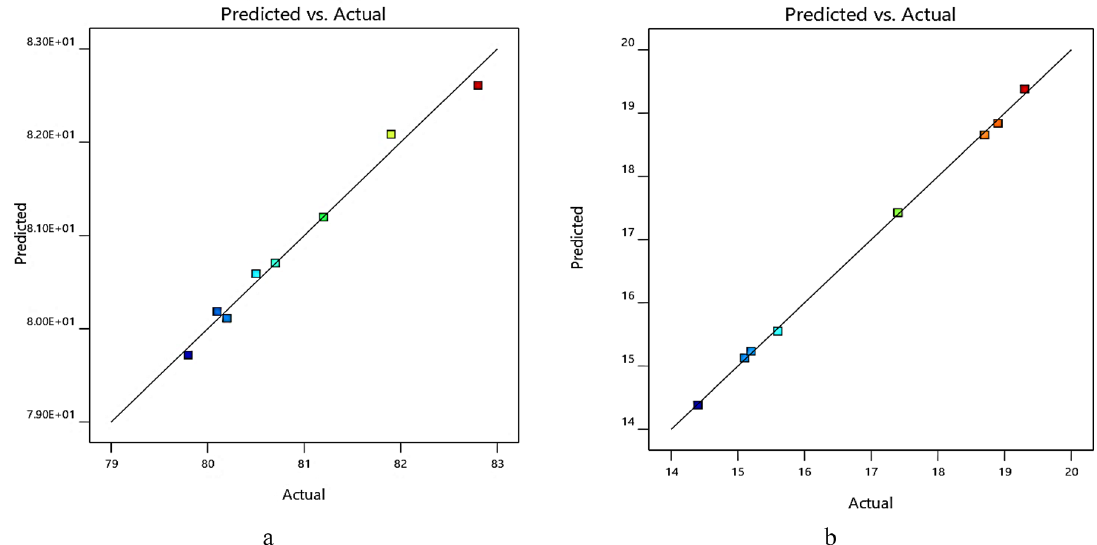
Figure 19. Results of the modeling and predicted values by the statistical model for ( a ) high permeability region of micromodel ( b ) low permeability region of